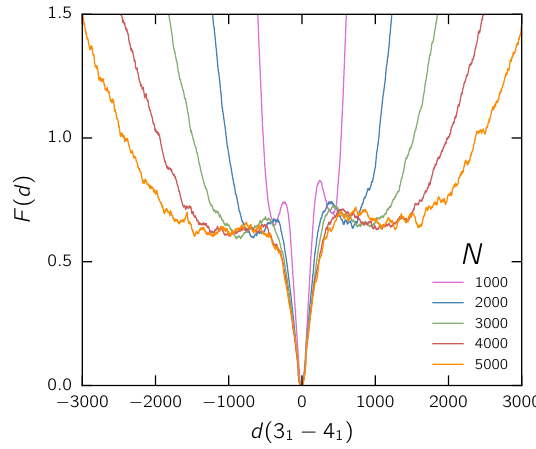
Figure 6. Size effect of free chains. Free energy landscape of the knot distance for different chain lengths composed of N